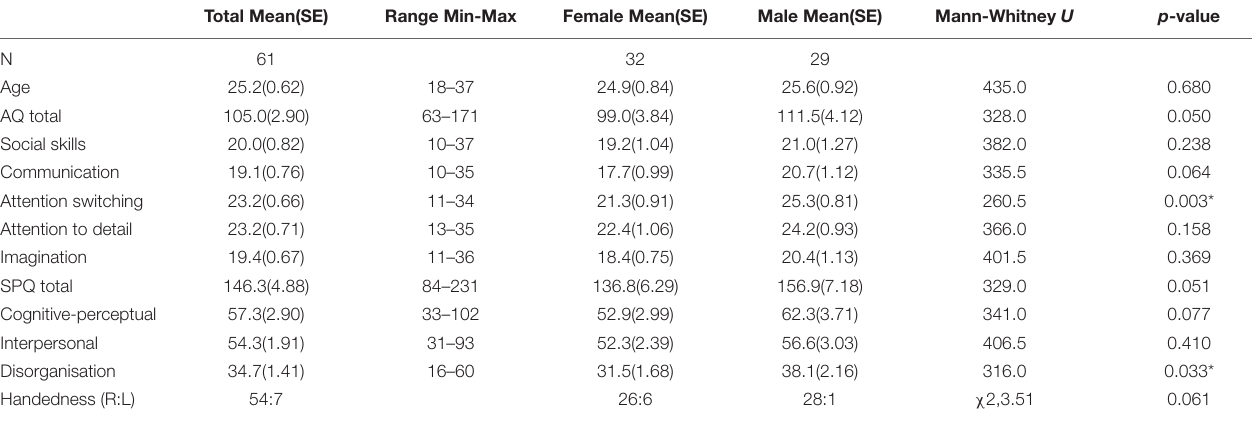
TABLE 1 | Final sample characteristics for full-scale autism spectrum quotient and schizotypal personality questionnaire total and dimension